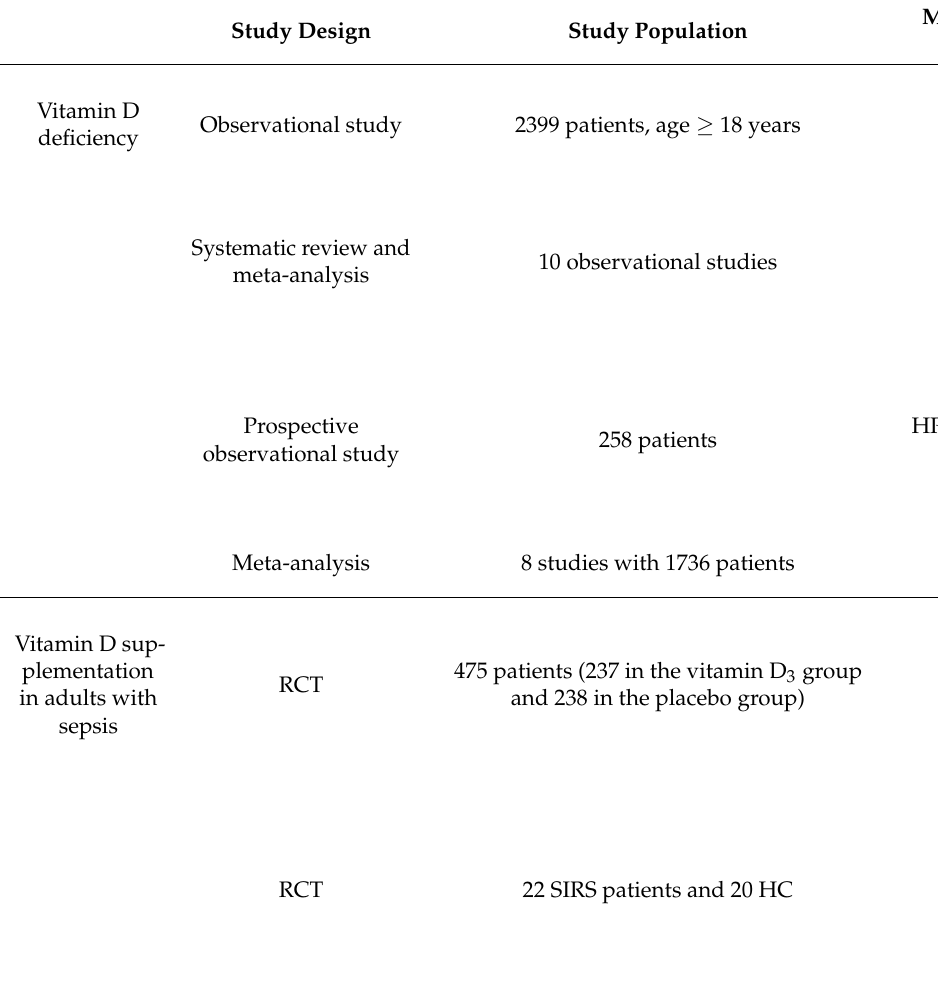
Table 2. Overview of studies investigating vitamin D deficiency and vitamin D supplementation in adults with